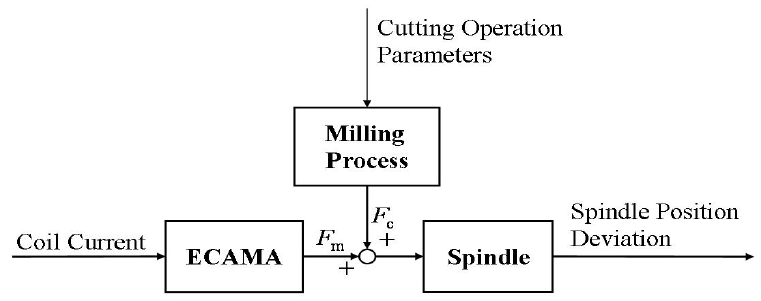
Figure 5. Block diagram of milling process regulated by the ECAMA.